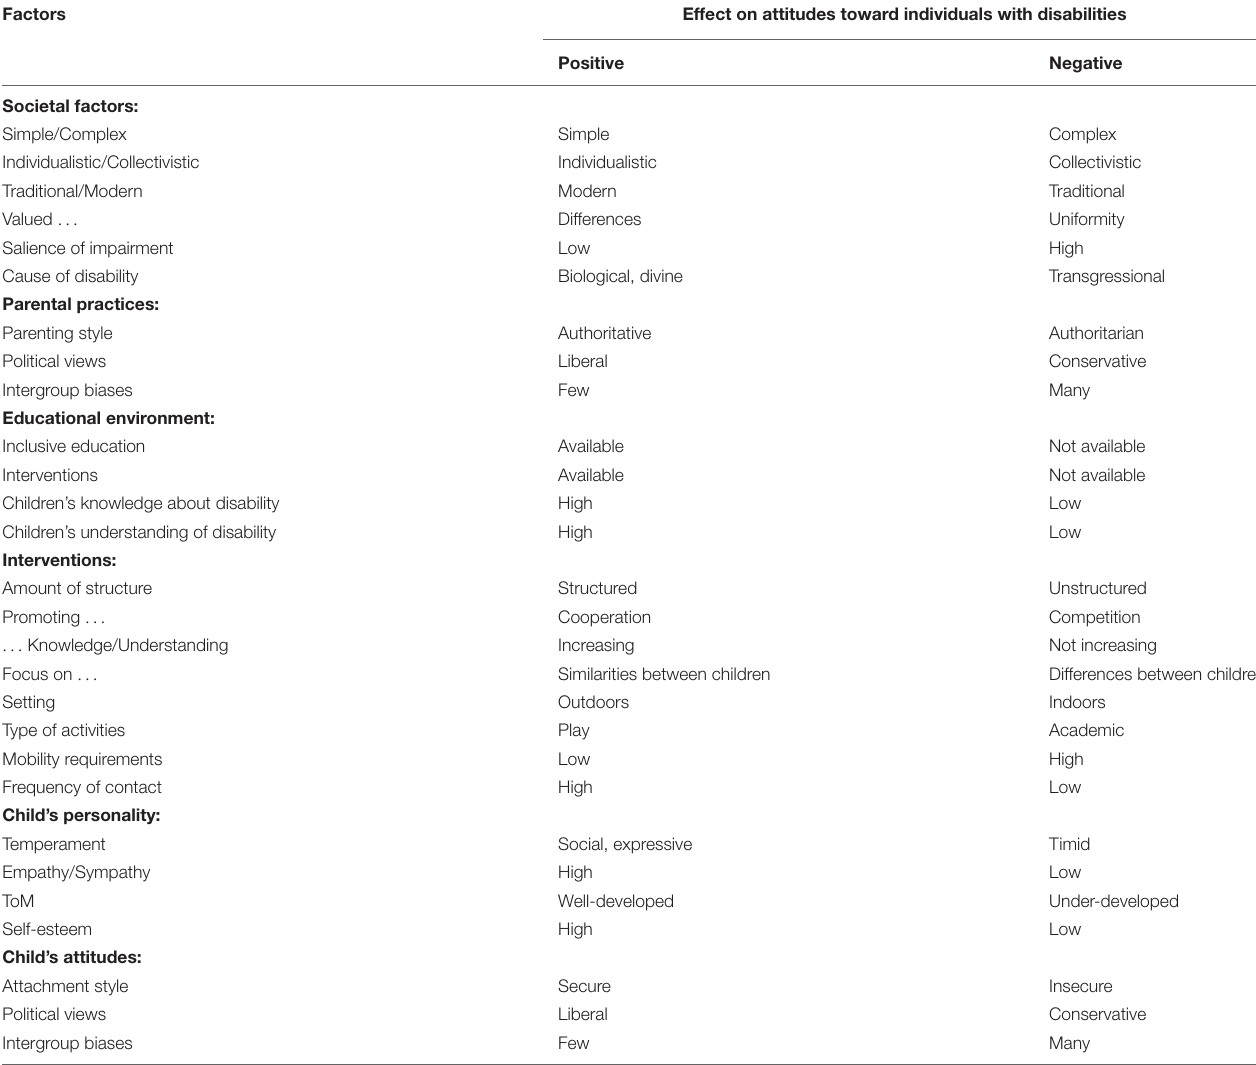
TABLE 1 | The outline of factors that affect perception of disability in a positive vs. negative way. Factors Effect on attitudes toward individuals with disabilities Positive Negative